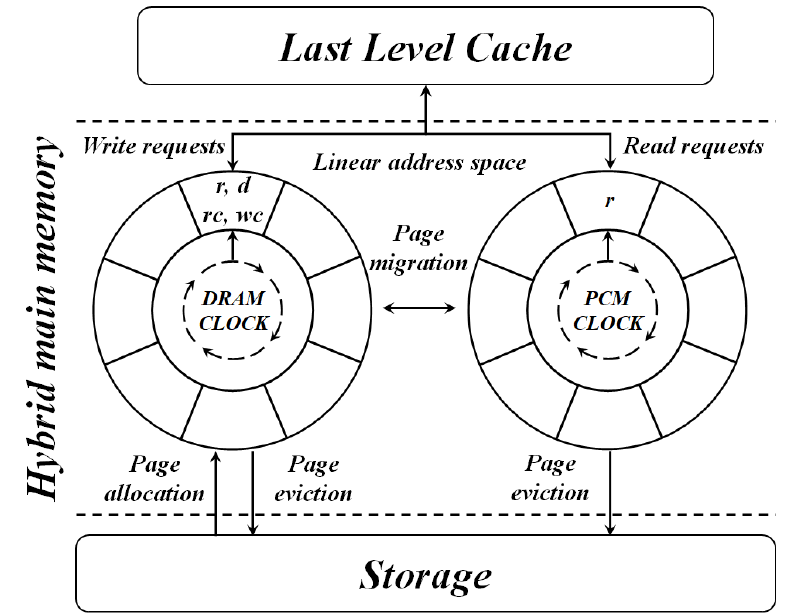
Figure 2. Structure of TA-CLOCK. Our policy comprises DRAM CLOCK and PCM CLOCK. The pages in the DRAM CLOCK maintain the reference bit r , dirty bit d , read counts rc , and write counts wc , and the pages in the PCM CLOCK maintain the reference bit r